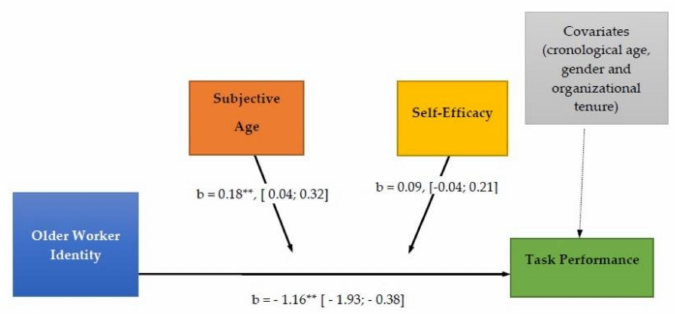
Figure 2. Results of moderation analysis. Note: [95% CI]; * p < 0.05; ** p < 0.01; *** p <